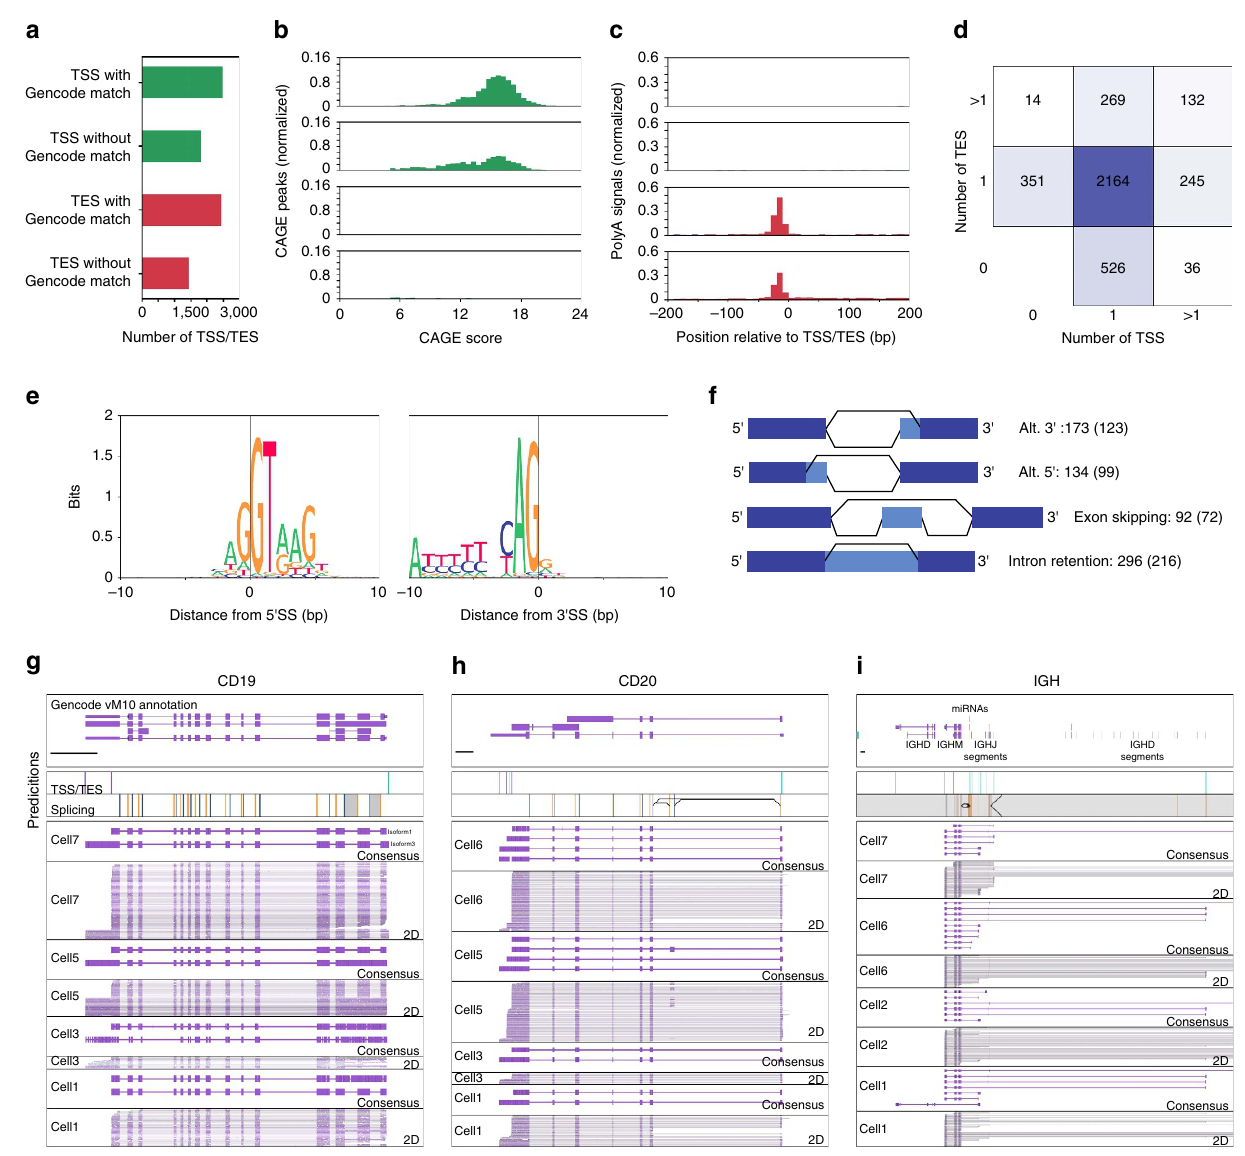
Figure 5 | Analysis of ONT RNAseq data identifies isoform features in mouse B1a cells. ( a ) TSSs and TESs predicted based on read data were separated into sites with or without GENCODE vM10 annotation matches. ( b , c ) TSSs/TESs with or without GENCODE matches were tested for FANTOM5 CAGE area enrichment ( b ) and polyA signals ( c ). ( d ) Overlap of TSSs and TESs with genes. Genes were sorted according to the number of TSSs and TESs they overlapped with. ( e ) Predicted base composition at 5 0 and 3 0 SS based on read data is shown as sequences logos. ( f ) Schematic for detection and corresponding number of detected alternative splice site combinations. Values in parentheses represent number of alternative splicing events validated using Illumina data. ( g – i ) Genome Browser view of CD19 , CD20 and IGH gene loci as shown in Fig. 4. ONT 2D reads and consensus sequence alignments are shown for the indicated cells. Splice sites for the highly repetitive IGH locus were not considered for isoform grouping due to the difficulty of aligning reads